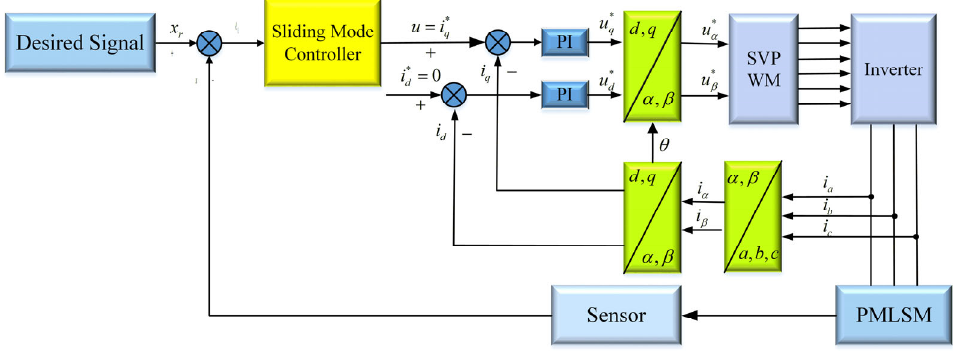
Figure 3. Classification of SMC-based PMLSM position control.